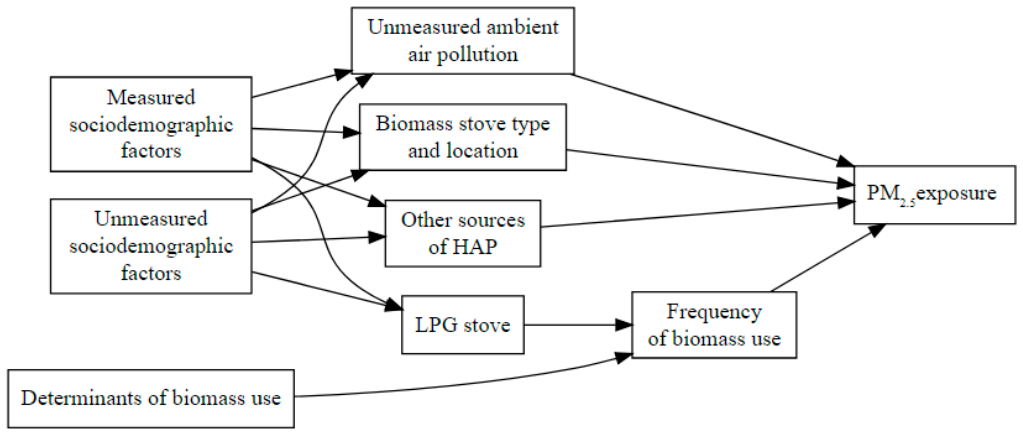
Figure 1. Directed acyclic graph of the hypothesized relationships between liquefied petroleum gas (LPG) stove ownership and exposure to personal fine particulate matter (PM 2.5 ).